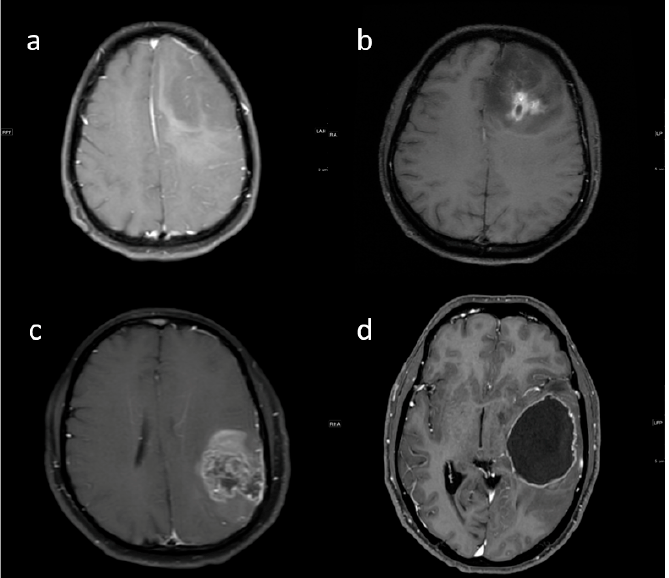
Figure 10. ( a – d ) T1 + C images from four patients showing various proportions of necrosis: ( a ) none, ( b ) < 25%, ( c ) 25–50%, and ( d ) > 50%.